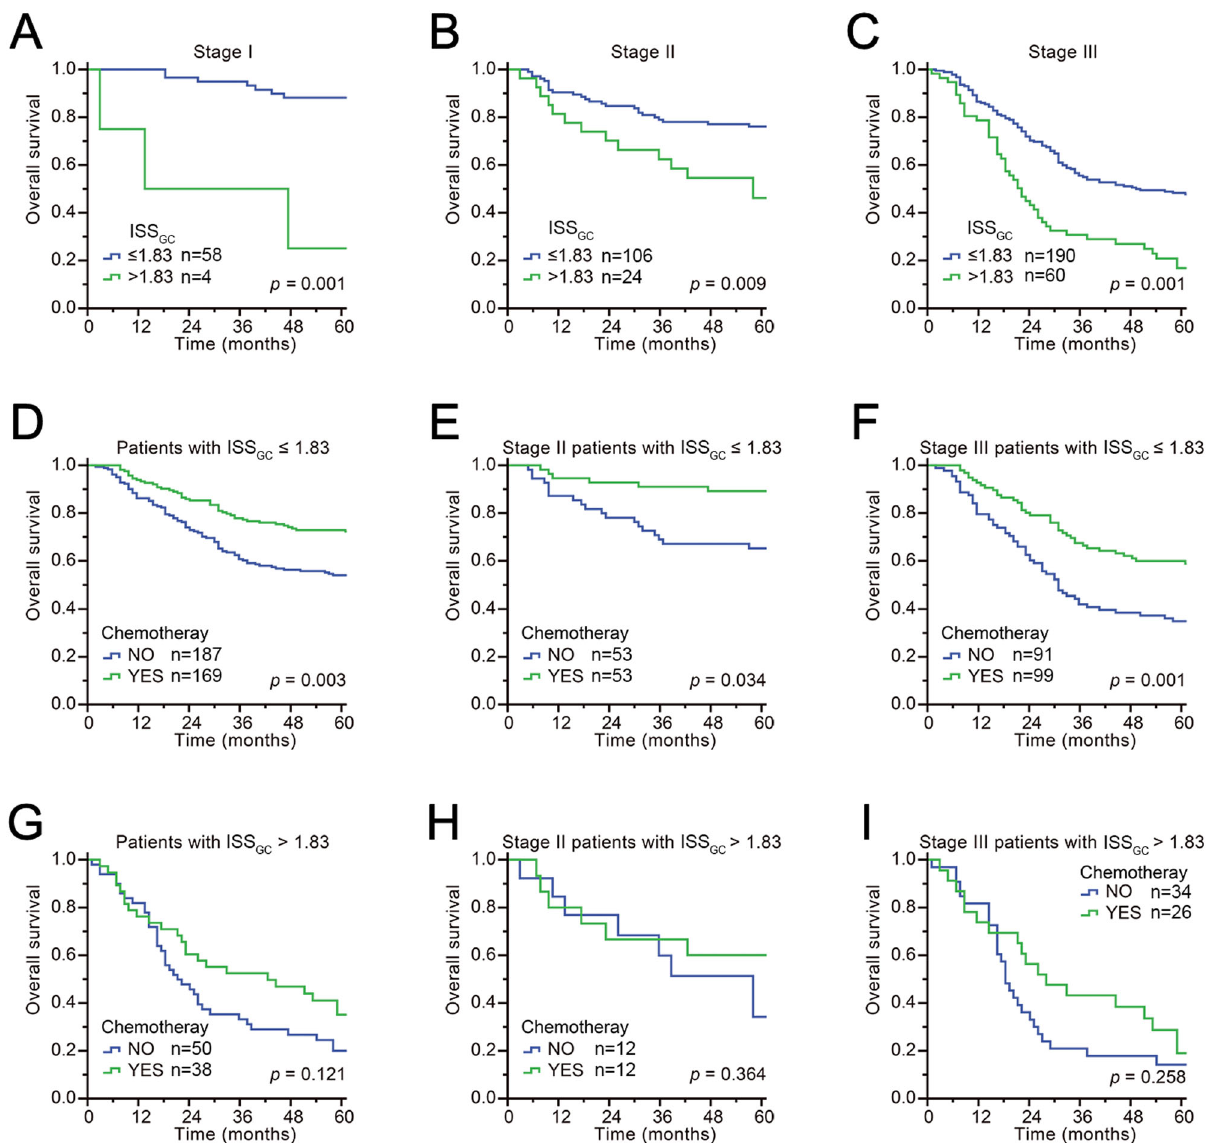
Fig. 4 Prognostic value of TNM stage and receipt of chemotherapy according to ISS GC strati fi cation. A – C Overall survival based on TNM stage in GC patients after ISS GC strati fi cation is presented using Kaplan – Meier curves. D – I Overall survival analysis of chemotherapy and TNM stage combined in GC patients after ISS GC strati fi cation is presented using Kaplan – Meier curves. p -Values for all survival analyses have been calculated using the log-rank